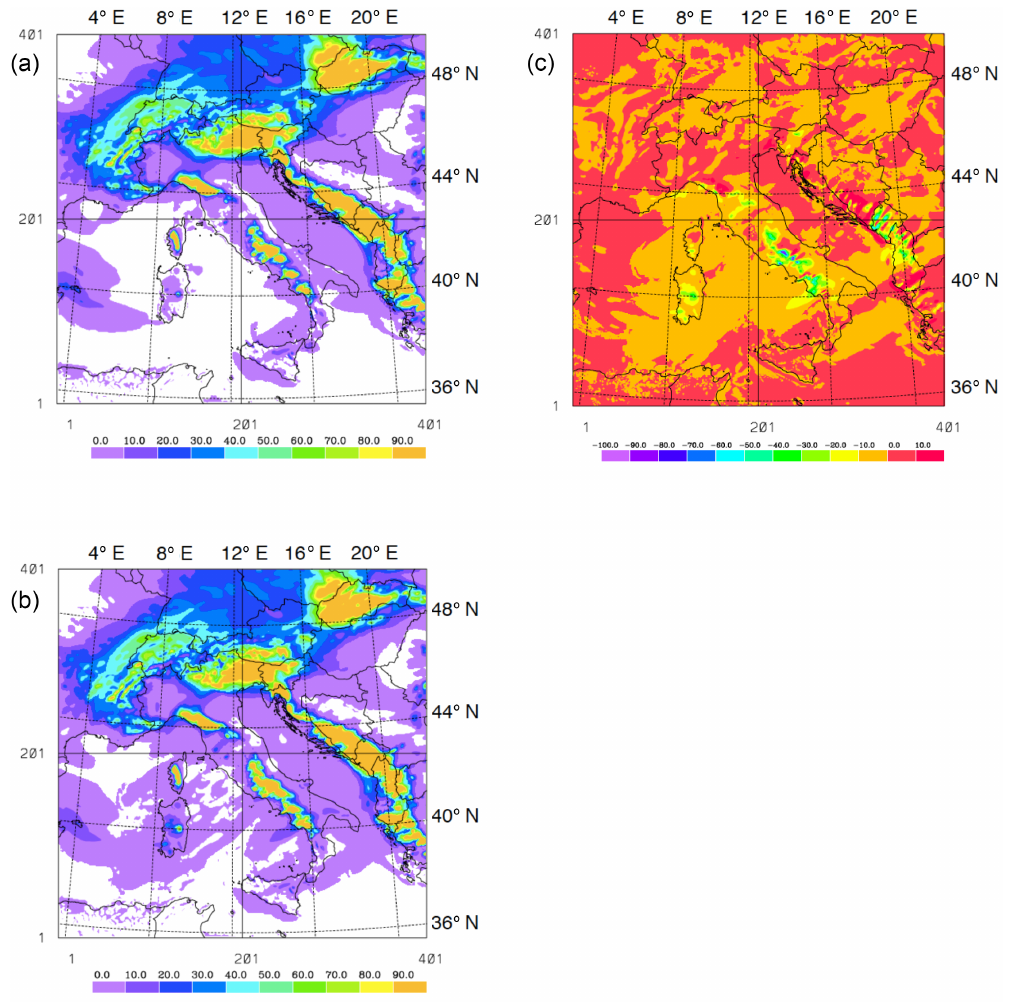
Figure 5. (a) Daily precipitation (mm) forecast of CNTRL (maximum value 300mm in Southern Italy; over NE Italy the maximum value is 135mm); (b) daily precipitation (mm) forecast obtained by summing the eight 3h forecasts of F3HA6 (the maximum value is 320mm in Southern Italy; over NE Italy the maximum simulated value is 132mm); (c) difference of daily precipitation (mm) between CNTRL and